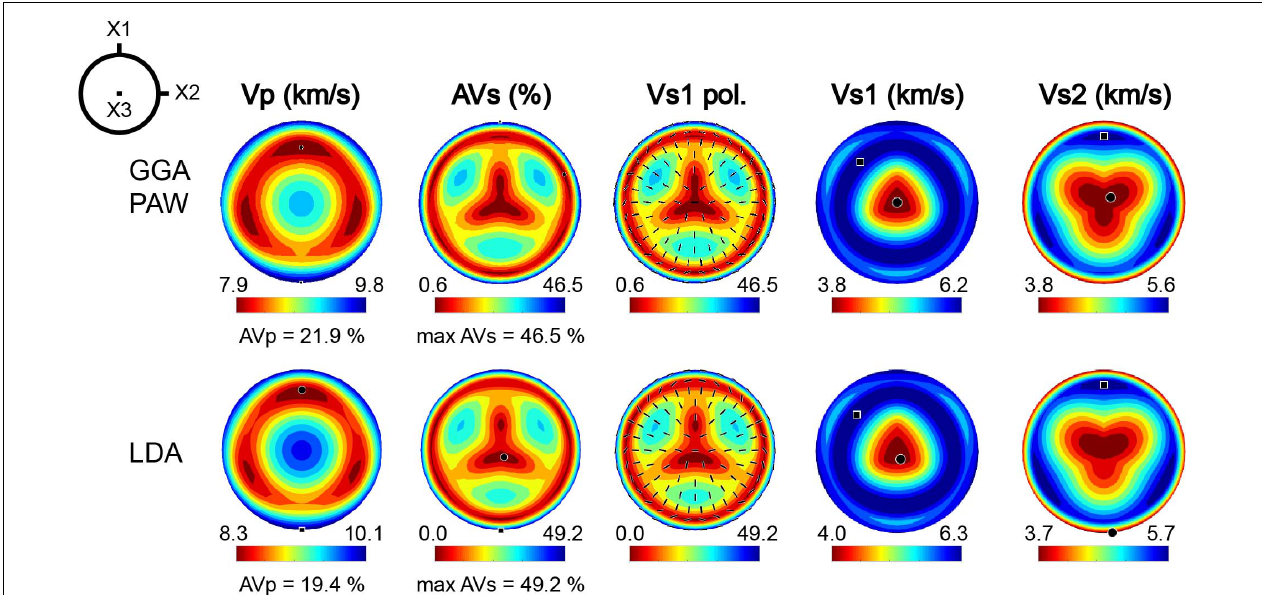
FIGURE 4 | Elastic anisotropy of single-crystal monoclinic chloritoid at a pressure of 0 GPa. The P-wave anisotropy was high (AV P = 21.9 and 19.4% for the GGA PAW and LDA methods, respectively) and the shear wave anisotropy was very high (max AV S = 46.5 and 49.2% for the GGA PAW and LDA methods, respectively). The polarization directions of the fast shear wave (V S1 polarized) are shown as black bars. A reference frame for monoclinic symmetry is shown on the left and depicts three orthogonal axes X1, X2, and X3, where X2 is parallel to the crystallographic b-axis and the plane normal to the b-axis is a mirror plane containing X1 and X3 (where X1 corresponds to the reciprocal a*-axis and X3 is parallel to the crystallographic c-axis). V P , P-wave velocity; AV S , shear wave anisotropy; V S1 pol, polarization direction of the fast S-wave; V S1 , fast S-wave velocity; V S2 , slow S-wave velocity.